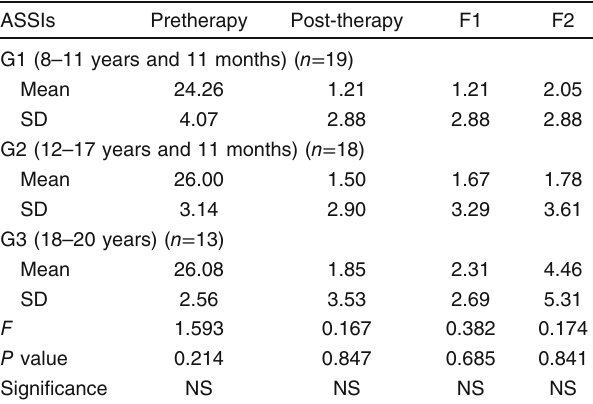
Table 14 Correlation between participants of the study group as regards stuttering severity during pretherapy, post- therapy, first follow-up and second follow-up evaluations